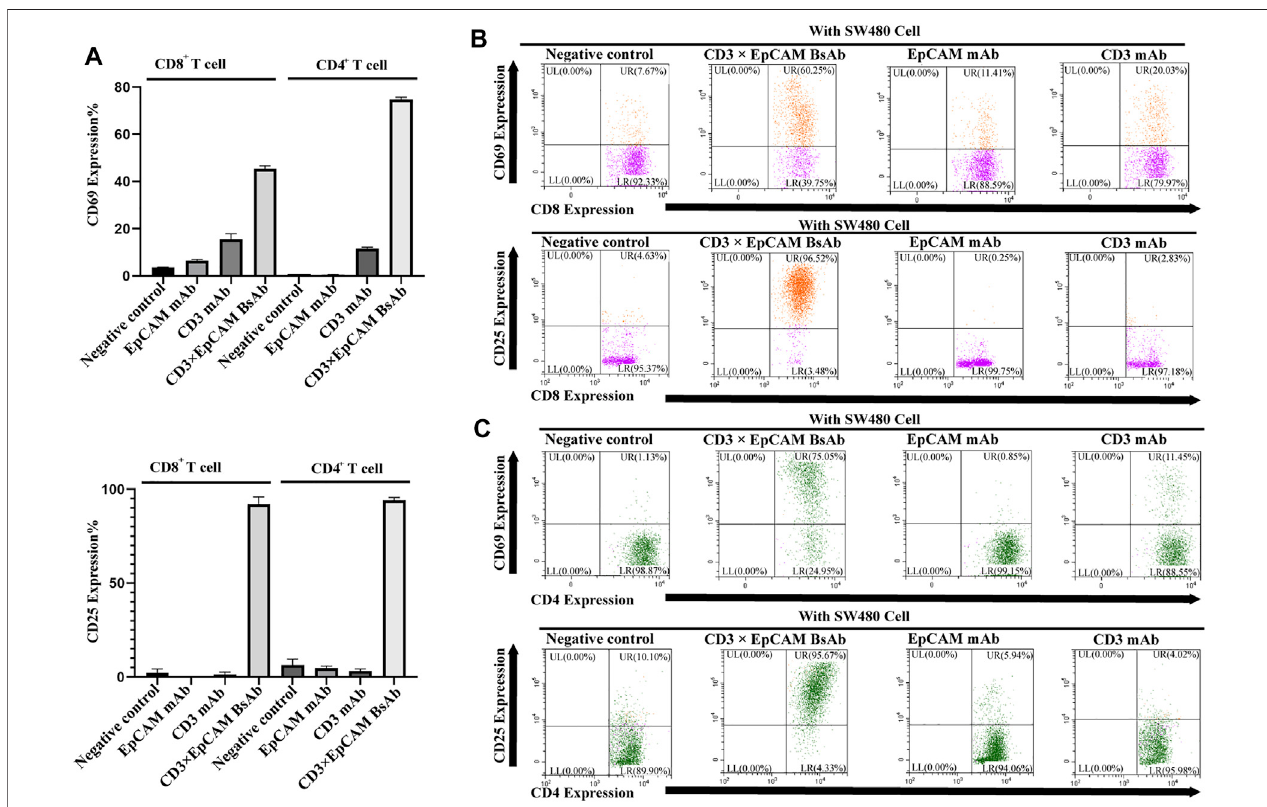
FIGURE 5 | T cell activation analysis mediated by CD3×EpCAM BsAb detected by fl ow cytometry. (A) The activation expression level of CD69 on T cells was detectedafterincubationfor24 handCD25for90 h(E:T=10:1). (B) TheactivationanalysisofCD8 + cellstotumorcellsbyCD3×EpCAMBsAb,EpCAMmAb,andCD3 mAb. (C) The cell activation analysis of CD4 + cells to tumor cells by CD3×EpCAM BsAb, EpCAM mAb, and CD3